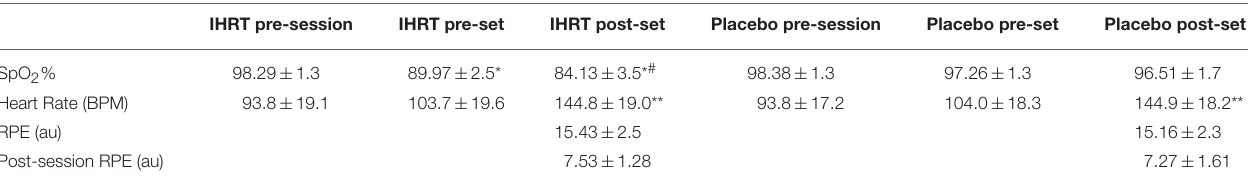
TABLE 3 | Average SpO 2 and Heart Rate values pre and post all sets for the duration of the training study and post-set RPE for each